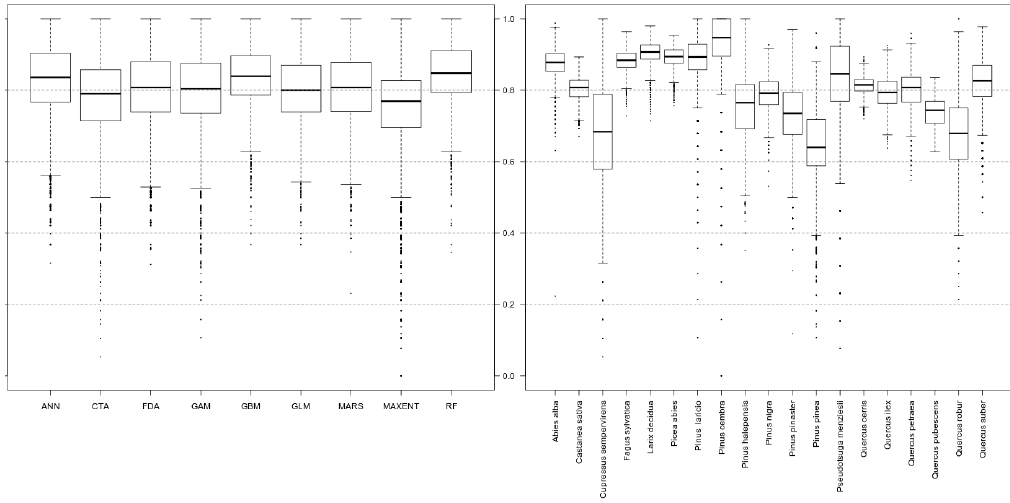
Figure 1. True Skill Statistic values (TSS) obtained during the cross-validation in the Species Distribution Modelling procedure for each involved algorithm ( left ) and for each species ( right ).